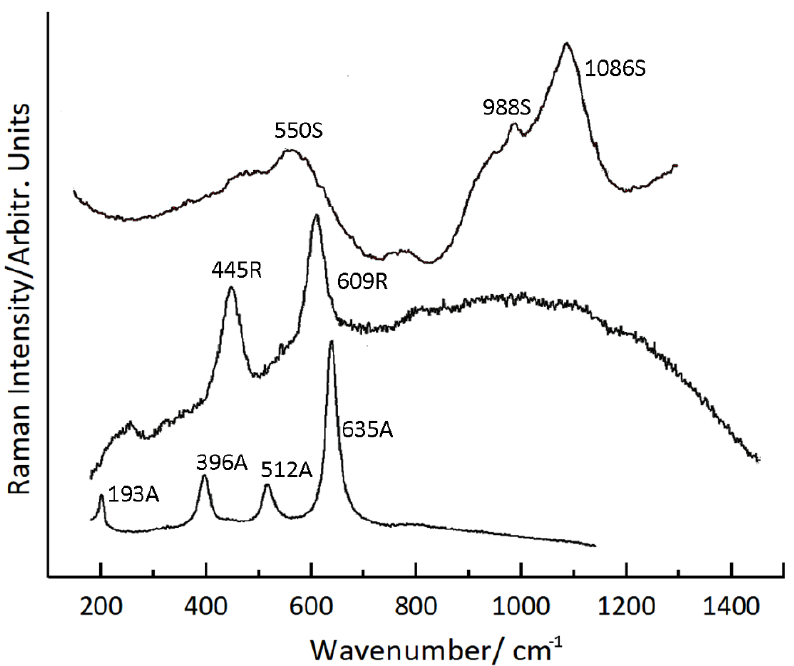
Figure 11. Raman spectra collected from red glass opaque tessera , 15117RV sample, in which anatase (A), rutile (R) and silica of the glassy matrix signals are identified.